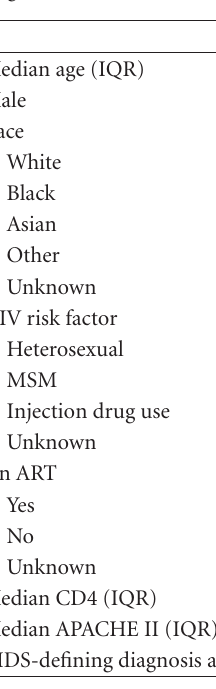
Table 1: Characteristics of the 43 patients included in this study. The second column is percentage, unless stated otherwise. IQR: interquartile range; ART: antiretroviral therapy; MSM: men who have sex with